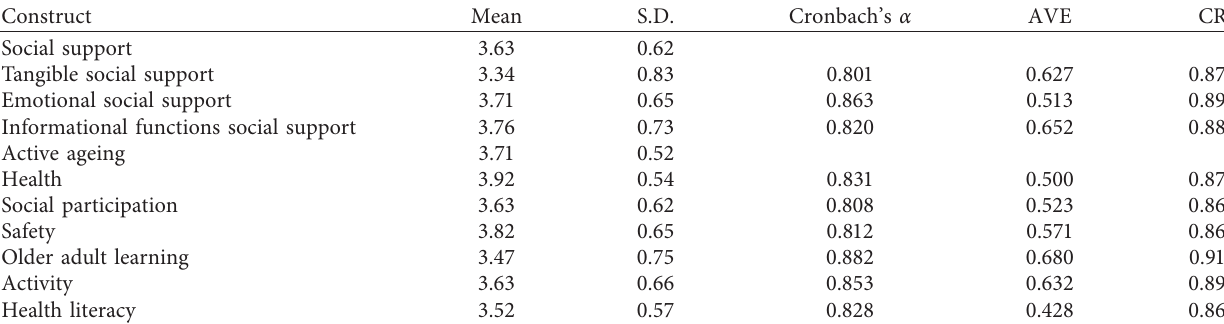
Table 2: Validity and reliability.